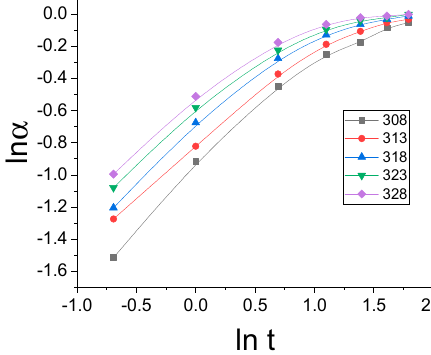
Figure 3 . Isothermal dependence of ln α on lnt. Figure 3. Isothermal dependence of ln α on lnt .